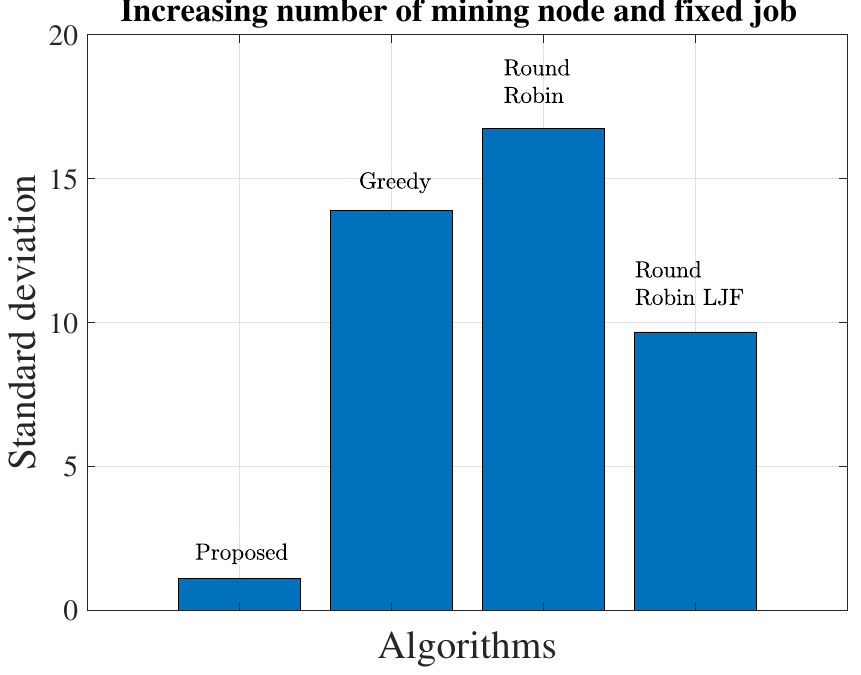
Figure 7. Standard deviation against a varying number of